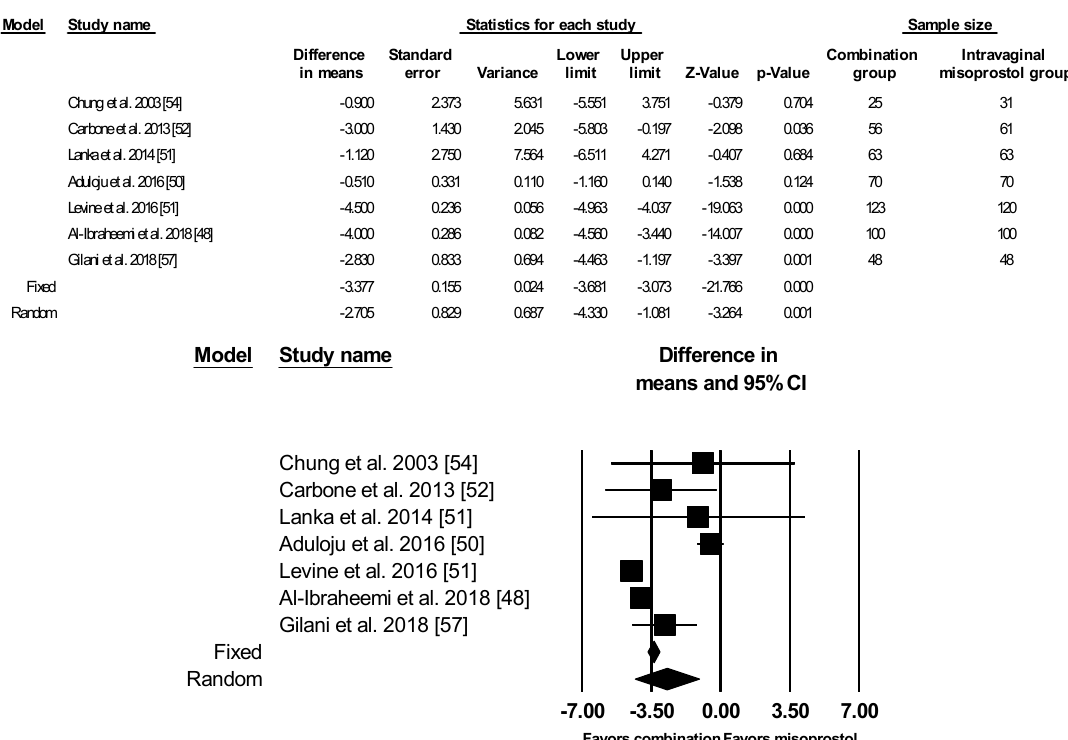
Figure 2. Comparison 1: Combination of intracervical Foley catheter and intravaginal misoprostol versus intravaginal misoprostol alone for cervical ripening, Outcome 1: Time to delivery. Heterogeneity: Tau 2 = 3.500; χ 2 = 104.455, df = 6 ( p = 0.000); I 2 = 94.256%. Test for overall effect (random): Z = − 3.264, ( p = 0.001).